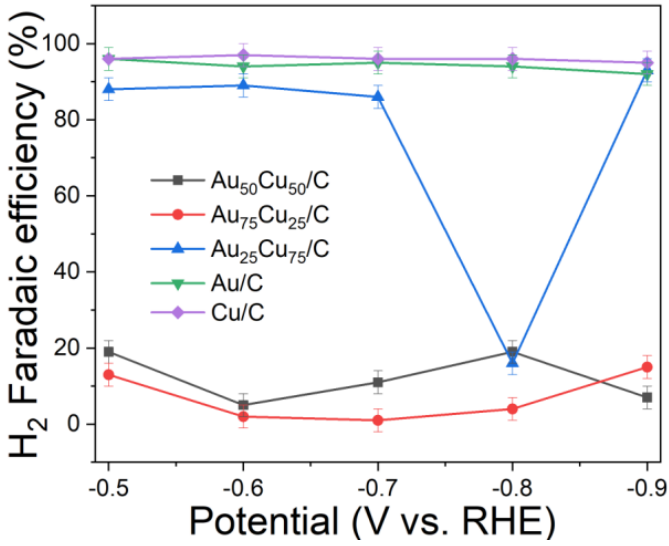
Figure 8. The H 2 FE of Au 25 Cu 75 /C, Au 50 Cu 50 /C and Au 75 Cu 25 /C, Au/C and Cu/C.